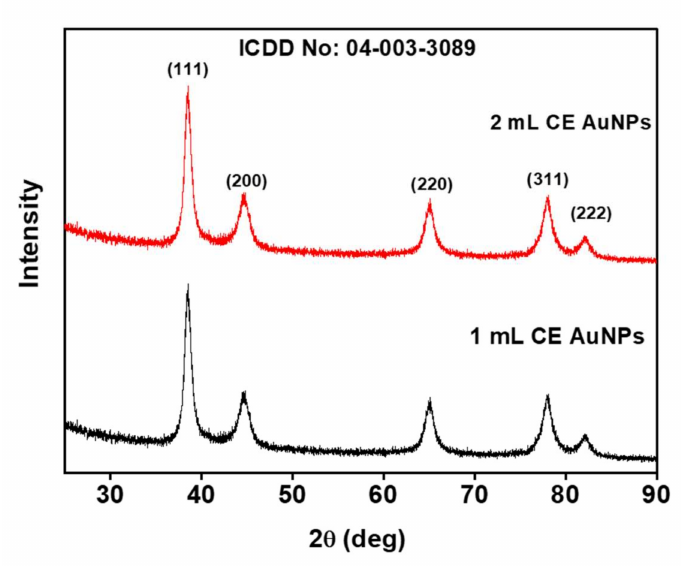
Figure 2. XRD patterns of the as-synthesized